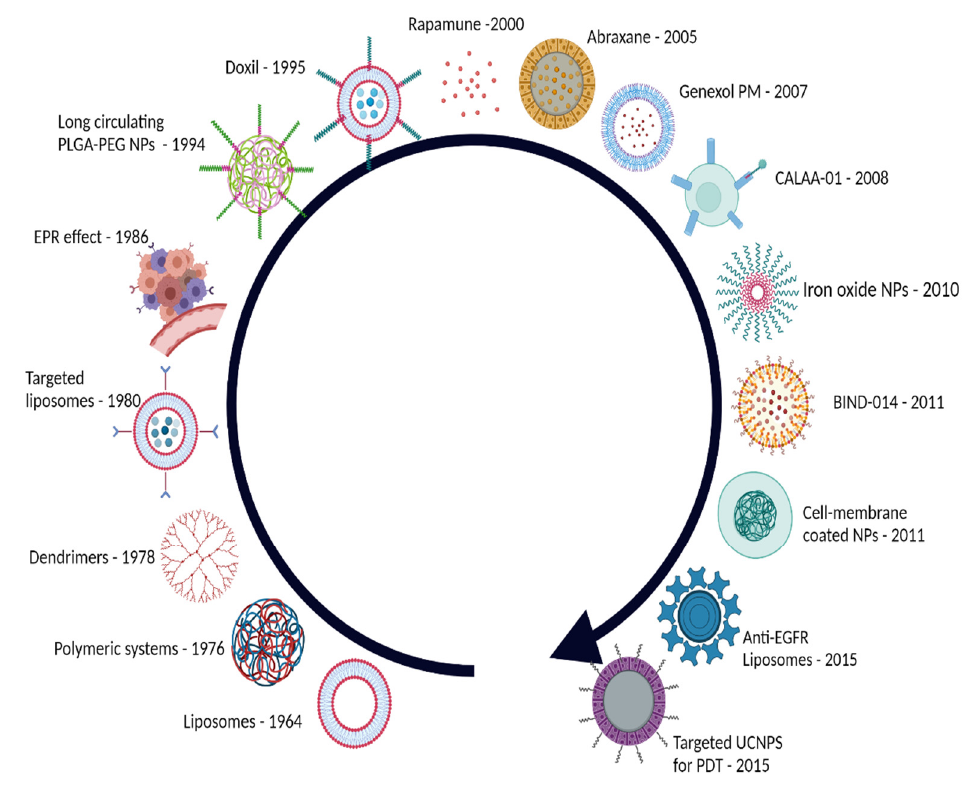
Figure 1. History of nanomedicine. EPR—enhanced permeability and retention; PLGA—poly (lactic-co-glycolic acid); PEG—polyethyleneglycol; UCNPs—upconverting nanoprticles; PDT—photodynamic therapy (created with BioRender.com).